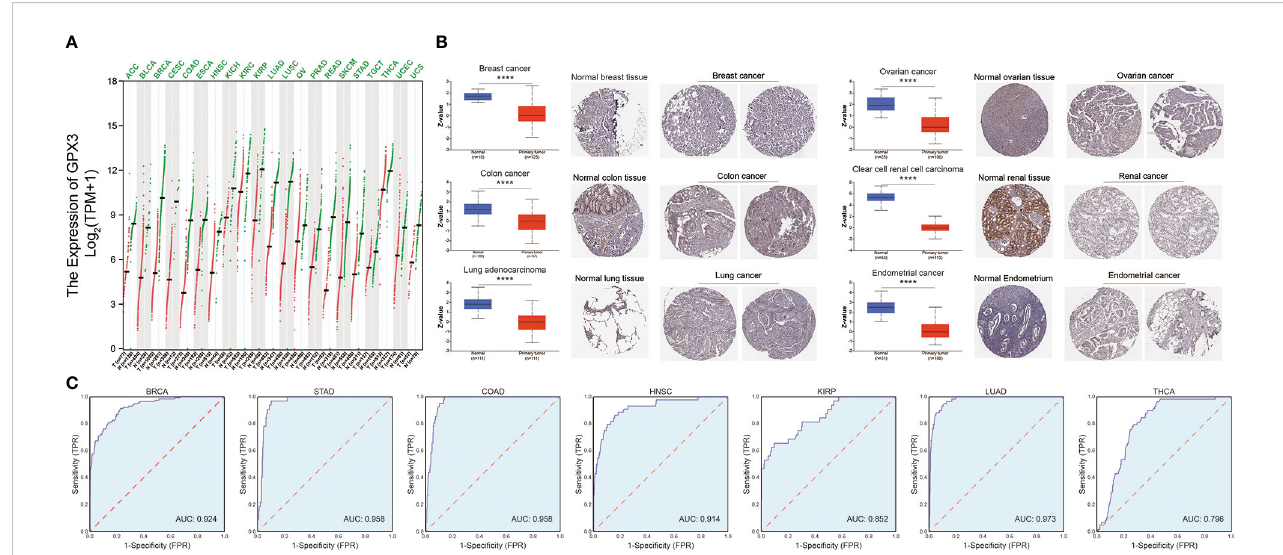
FIGURE 1 The expression of GPX3 in human cancer. (A) The expression of the GPX3 gene in pan-cancer was explored in TCGA and GTEx database. (B) Based on the CPTAC analysis and the HPA database, the expression of the GPX3 protein. (C) ROC analysis of GPX3 gene in TCGA